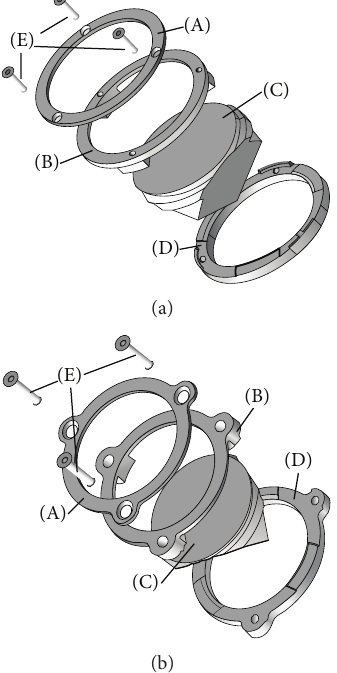
Figure 4: Comparison of LAGEOS (a) and LARES (b) cube corner reflector mounting systems. (A) Retainer ring, (B) plastic upper mounting ring, (C) CCR, (D) plastic lower mounting ring, and (E) screws.